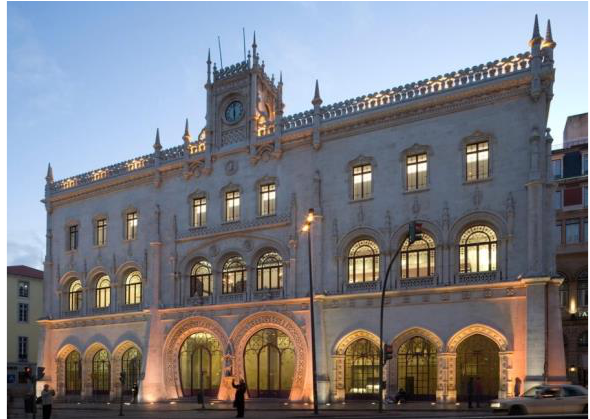
Figure 1. Estaçao Ferroviaria do